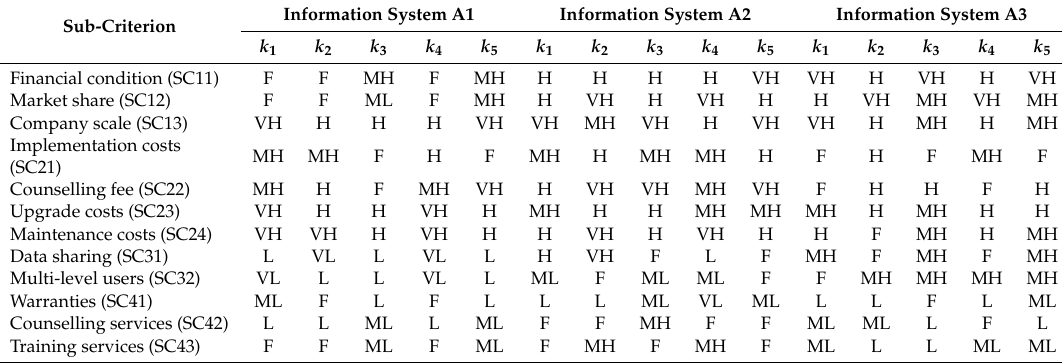
Table 8. Performance evaluation of the three information systems by the experts.